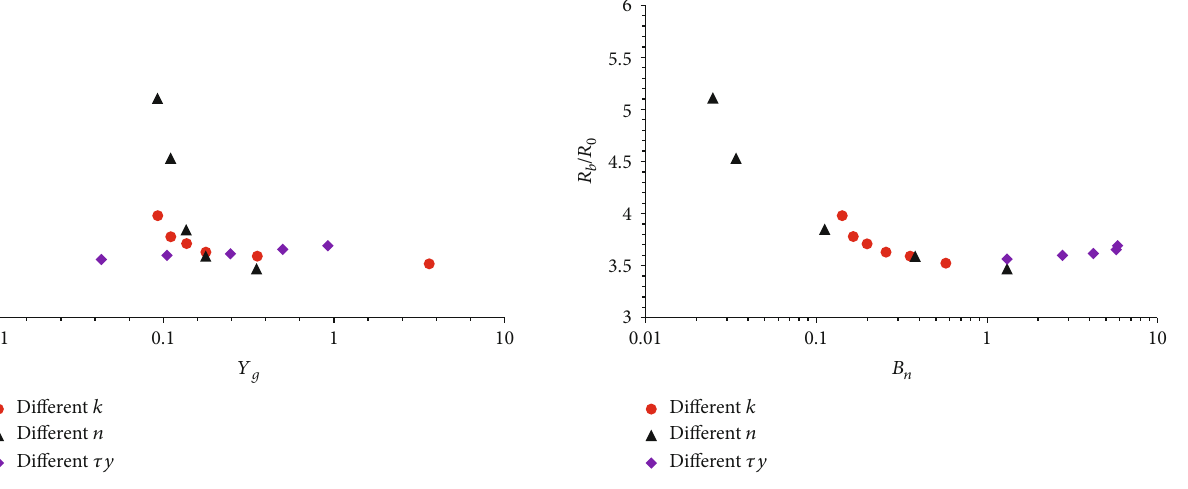
Figure 13: Variation of dimensionless equivalent radius of detached value. bubble with the B n